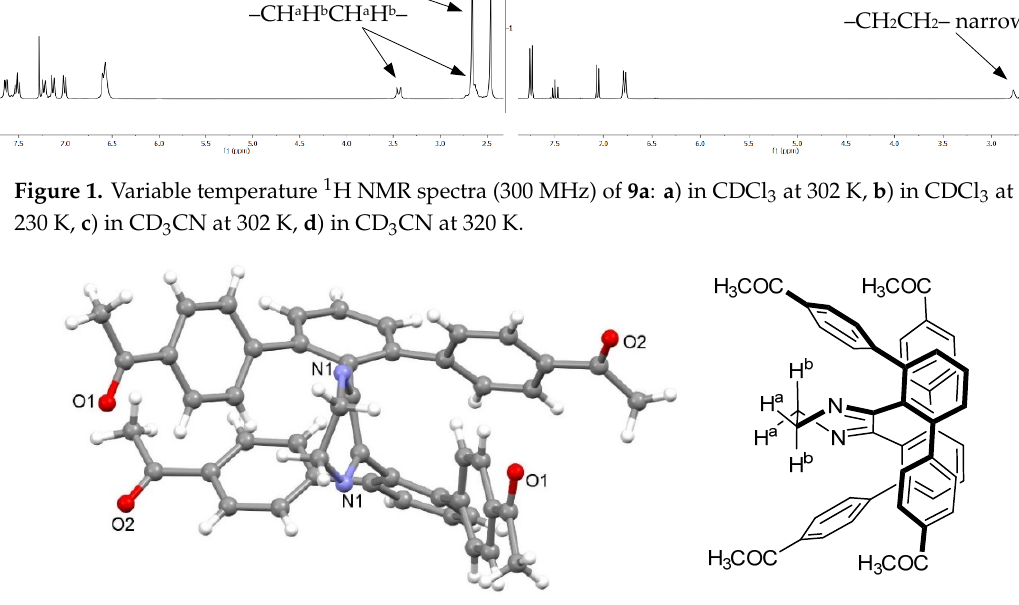
Figure 2. X-ray structure of 9a and its possible conformation at low temperature.